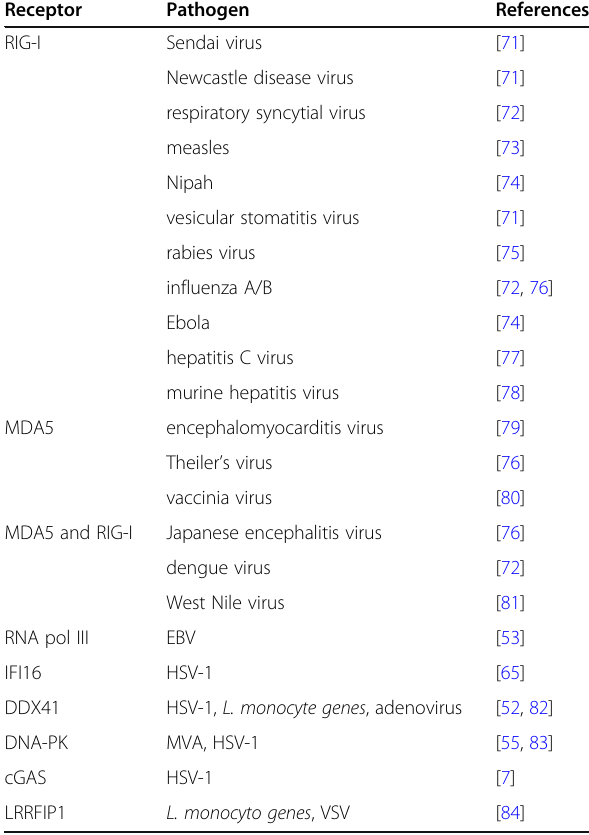
Table 1 Pathogens and corresponding receptors in cells Receptor